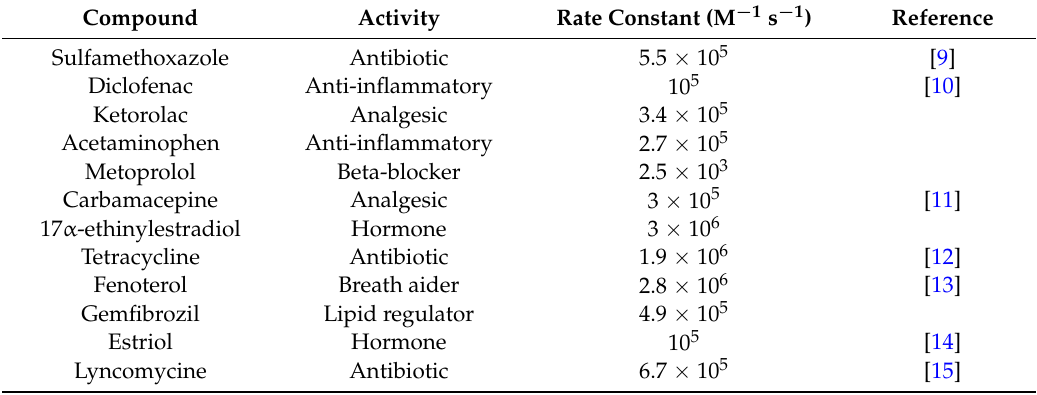
Table 1. Rate constants of ozone reactions with some pharmaceuticals found in urban wastewater